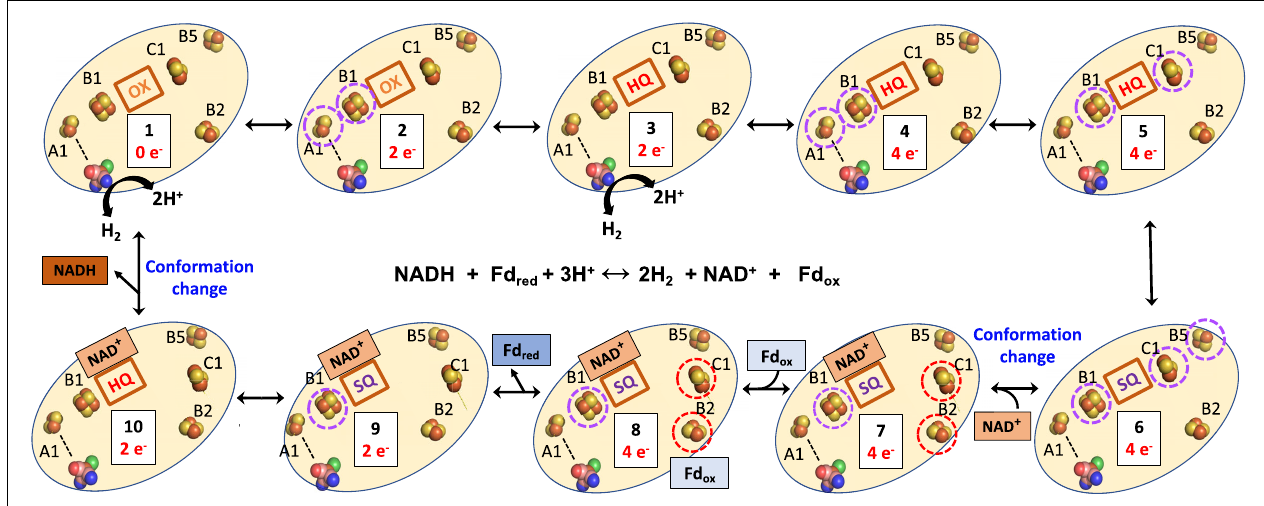
FIGURE 11 | Hypothetical mechanism of electron bifurcation in NiFe-Bfu hydrogenase. The FeS clusters A2, A3, and S1 that link A1 and the NiFe site (see Figure 1 ) are represented by a dotted line. Not shown are clusters B3 and B4, which are proposed to transfer electrons from B2 to Fd. Low and medium potential redox centers are indicated by red and purple dotted circles, respectively. The FMN is indicated by its redox state as either oxidized (OX), the semiquinone (SQ), or the reduced hydroquinone (HQ). The binding of NADH to the FMN site is predicted to cause a conformational change leading to movement of the C1 cluster away from the flavin toward the B2 cluster. The reverse process occurs when NADH leaves.